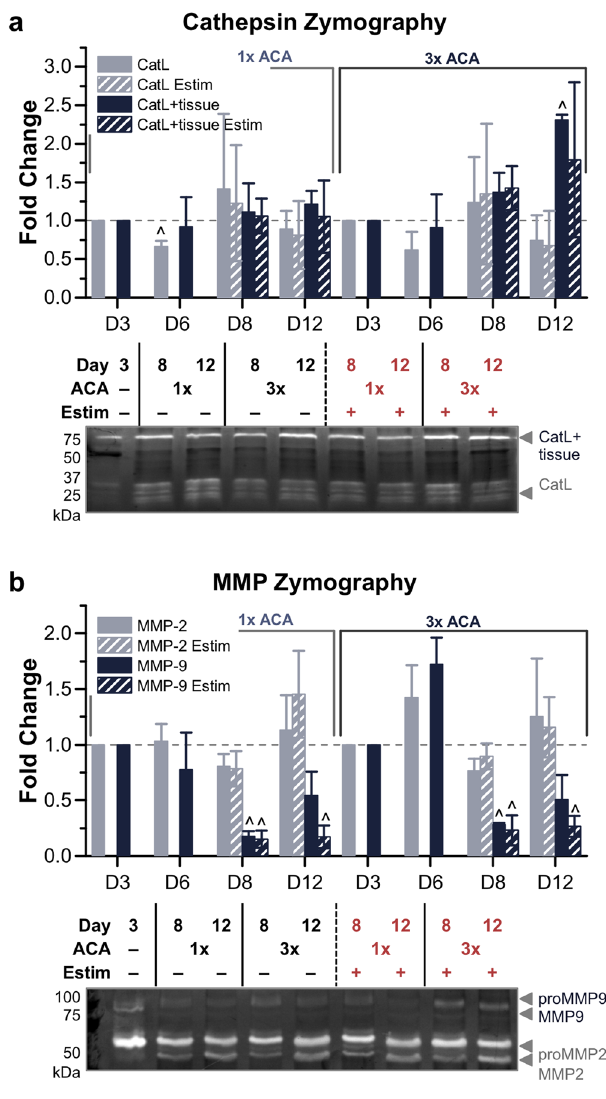
Figure 5. Gelatin Zymography of Cathepsins and MMPs with 1x and 3x ACA. ( a ) Cathepsin zymography identified the amount of active CatL and CatL + tissue at days 3, 6, 8 and 12, in the presence or absence of electrical stimulation, for 1x and 3x ACA ( n = 3–6 muscle strips per condition). ( b ) MMP zymography identified the amount of active MMP-2 and MMP-9 at days 3, 6, 8 and 12, in the presence or absence of electrical stimulation, for 1x and 3x ACA ( n = 4–7 muscle strips per condition). All plots represent mean ± SEM. ^ indicates significance ( p < 0.05) compared to initial time